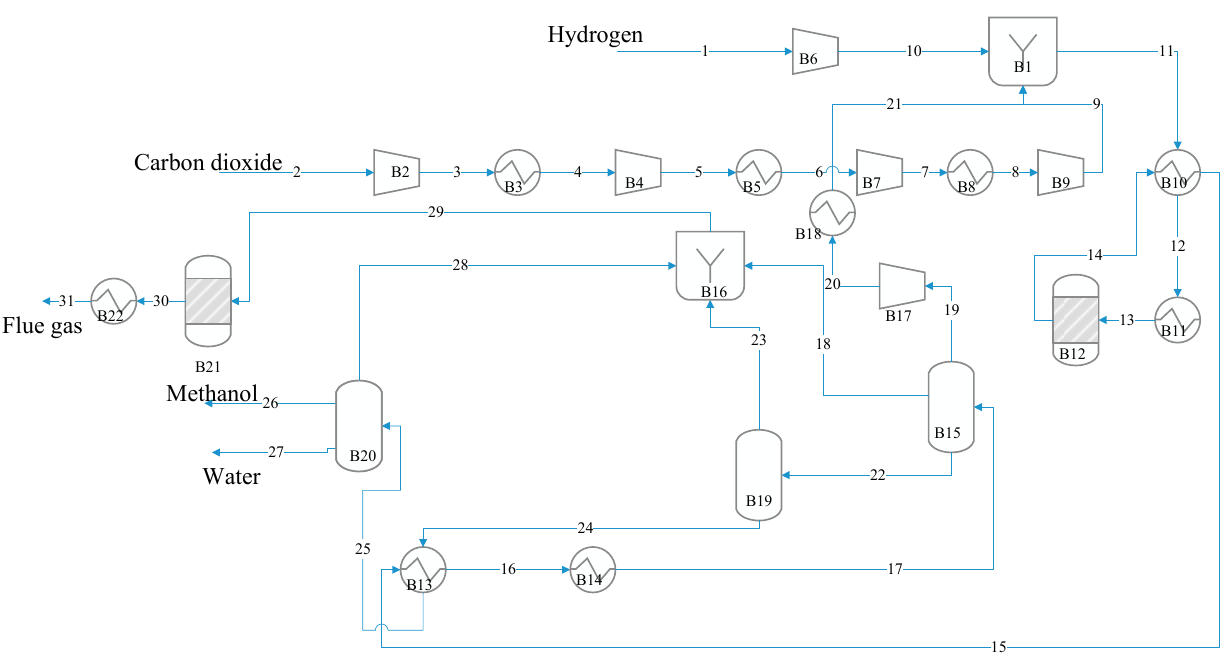
Figure 8. Schematic diagram of the methanol synthesis process. Major equipment: (B2, B4, B6, B7, B9) compressor for feed compression; (B3, B5, B8) compressed feed cooler; (B10, B11) heat exchanger for feed preheating; (B12) methanol synthesis reactor; (B13, B14) heat exchanger (cooler); (B15, B19) flash separator; (B20) distillation column.